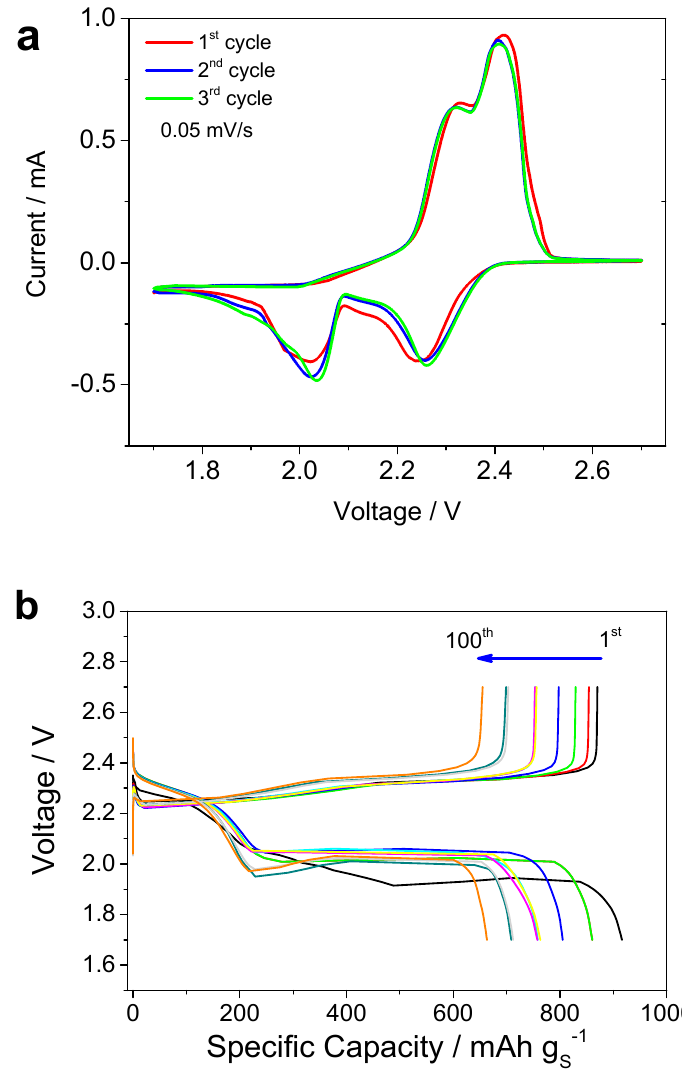
Figure 6. ( a ) Cyclic voltammetry (CV) curves of ASC/S composite measured in the potential window of 1.7–2.7 V at a scan rate of 0.05 mV s − 1 . ( b ) Discharge/charge curves of ASC/S composite recorded at a current of 100 mA g − 1 .